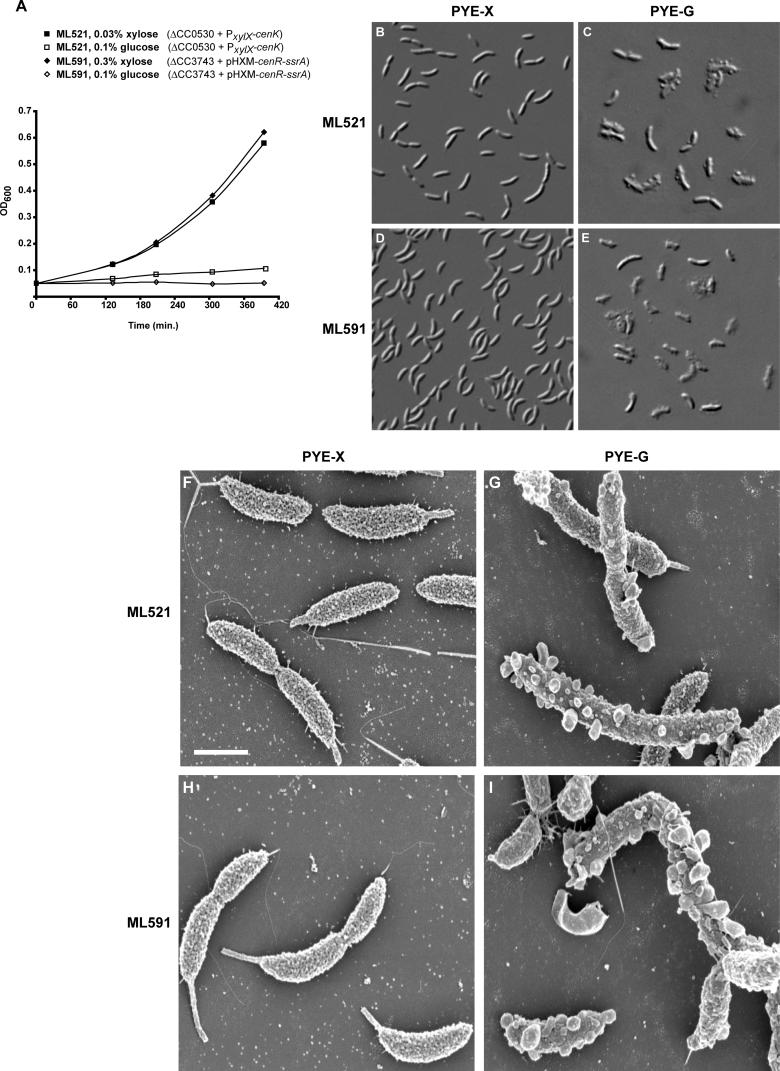
CC0530 (cenK) and CC3743 (cenR) Are Essential for Growth and Required for Cell Envelope IntegrityGrowth curves for the ML521 (ΔCC0530 + PxylX-cenK) and ML591 (ΔCC3743 + pHXM-cenR-ssrA) depletion strains (A). Overnight cultures of each were grown in PYE plus xylose (PYE-X), washed with plain PYE, and diluted in PYE plus xylose or PYE plus glucose (PYE-G). After 12 h of growth in these conditions cells reached an optical density (OD600) level that could be measured (this time is plotted as “0 min”). Morphology was observed by light microscopy for the cenK depletion (ML521) after a total of 20 h in PYE plus xylose (B) or PYE plus glucose (C) and for the cenR depletion (ML591) after 20 h in PYE plus xylose (D) or PYE plus glucose (E). Scanning electron micrographs under identical conditions are shown for ML521 in PYE plus xylose (F) and PYE plus glucose (G) and for ML591 in PYE plus xylose (H) and PYE plus glucose (I). For (F–I), scale bar represents 1 μm. Depletion of either gene product led to an unusual, irregular blebbing of the cell surface. Cells were not motile, and had reduced stalk length.